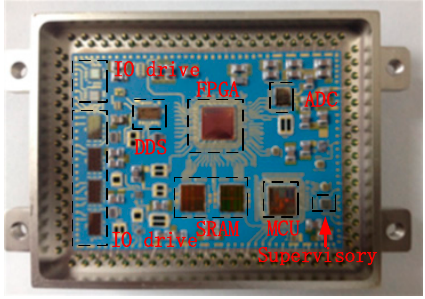
Figure 6. Internal structure of the SiP.